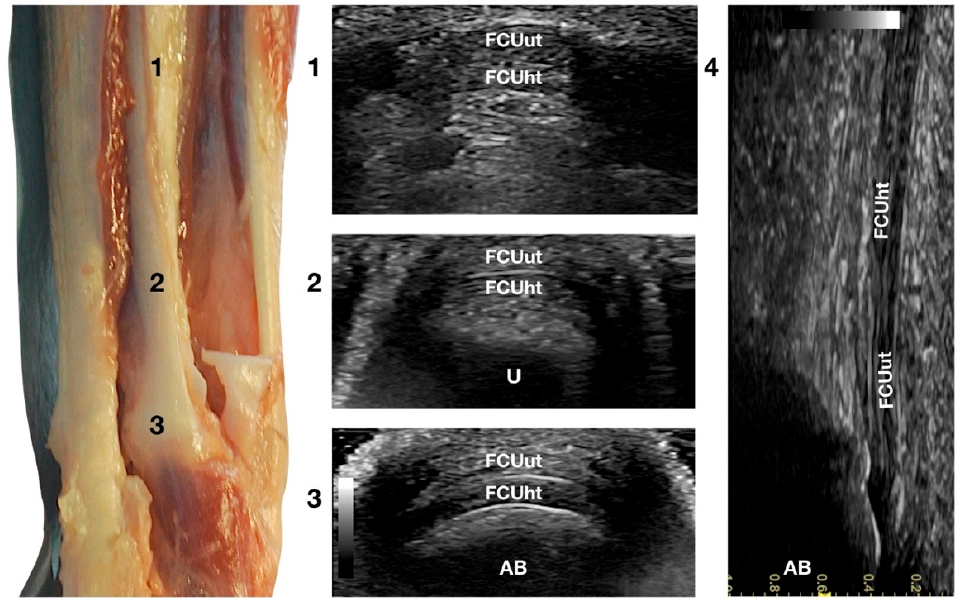
Figure 6. Palmar carpal face centred on the Flexor Carpi Ulnaris tendon. Part of the distal attachment of the FCUut covering the FCUht was removed to show the thicker, deeper portion. At the ulnar notch level (2), the FCUt is a broad and flattened elliptical tendon subdivided into two nearly equal parts by a thin hyperechoic line. Some fat separates the tendon from the deeper osseous contour of the distal portion of the ulna (U). Proximally, at the tenomuscular junction (1), the combination of the two-part forms a rounder and narrower tendon. The tendon becomes thinner and more expansive due to the insertion based on the accessory carpal bone (AB) (3). On the longitudinal scan plane (4), the prominent fibrillar pattern of the tendon components is visible.